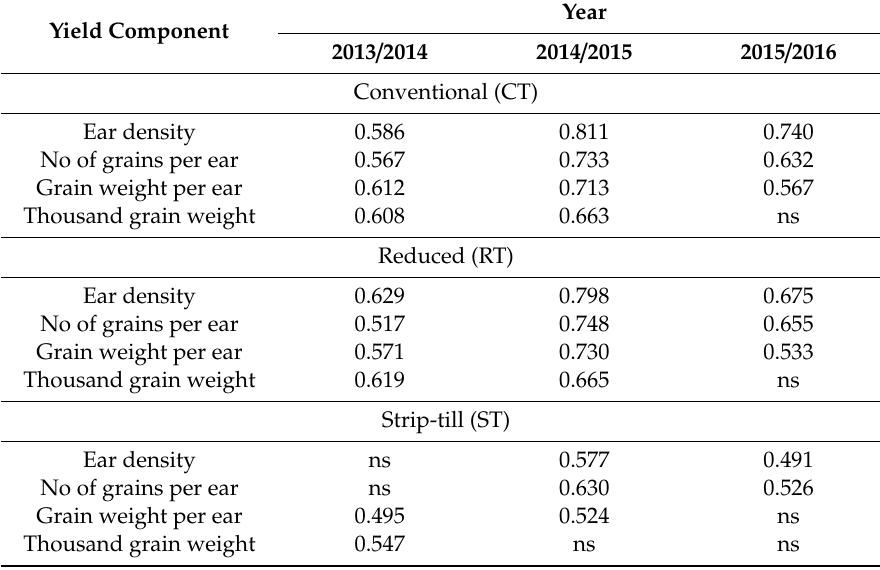
Table 4. Pearson’s correlation coe ffi cients between the soil moisture during the growing season of winter wheat and its yield components depending on the basic tillage, pre-sowing fertilisation, and sowing technology ( N =